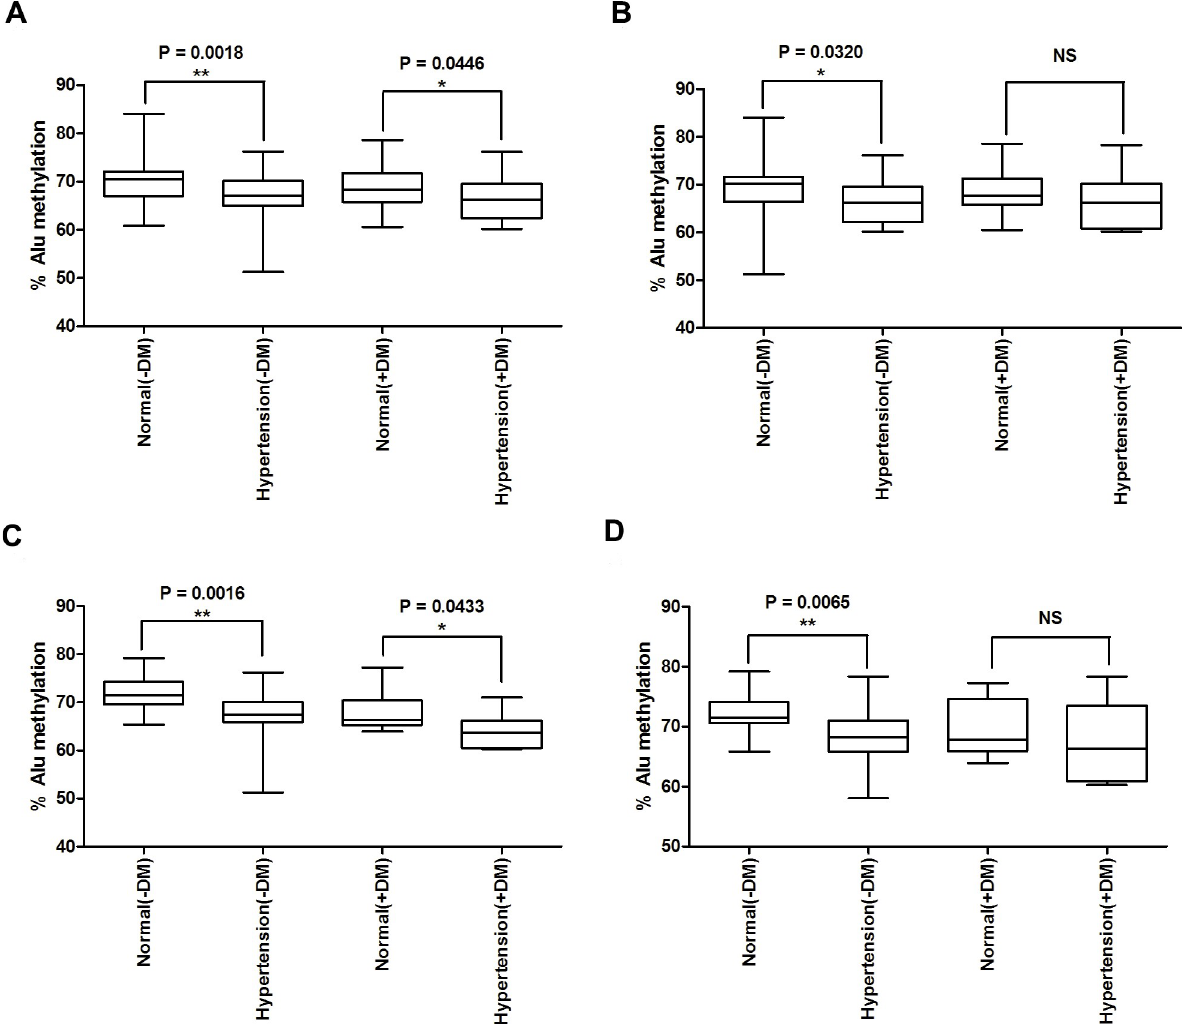
Fig 4. The percentages of the Alu methylation levels in normal controls and hypertensive patients. (A) Normal controls without diabetes (Normal(-DM)) compared with hypertension without diabetes (Hypertension(-DM)) and normal controls with diabetes (Normal(+DM)) compared with hypertension with diabetes (Hypertension(+DM)) when classify by the systolic pressure indicator and (B) by the diastolic pressure indicator. (C) In age-matched pairs classify by the systolic pressure indicator and (D) by the diastolic pressure indicator. The percentages of Alu methylation are shown as box plots, with the boxes representing the interquartile ranges (25th to 75th percentile) and the median lines representing the 50th percentile. The whiskers represent the minimum and maximum values. � P < 0.05, �� P < 0.01 (t-test) (Mann–Whitney